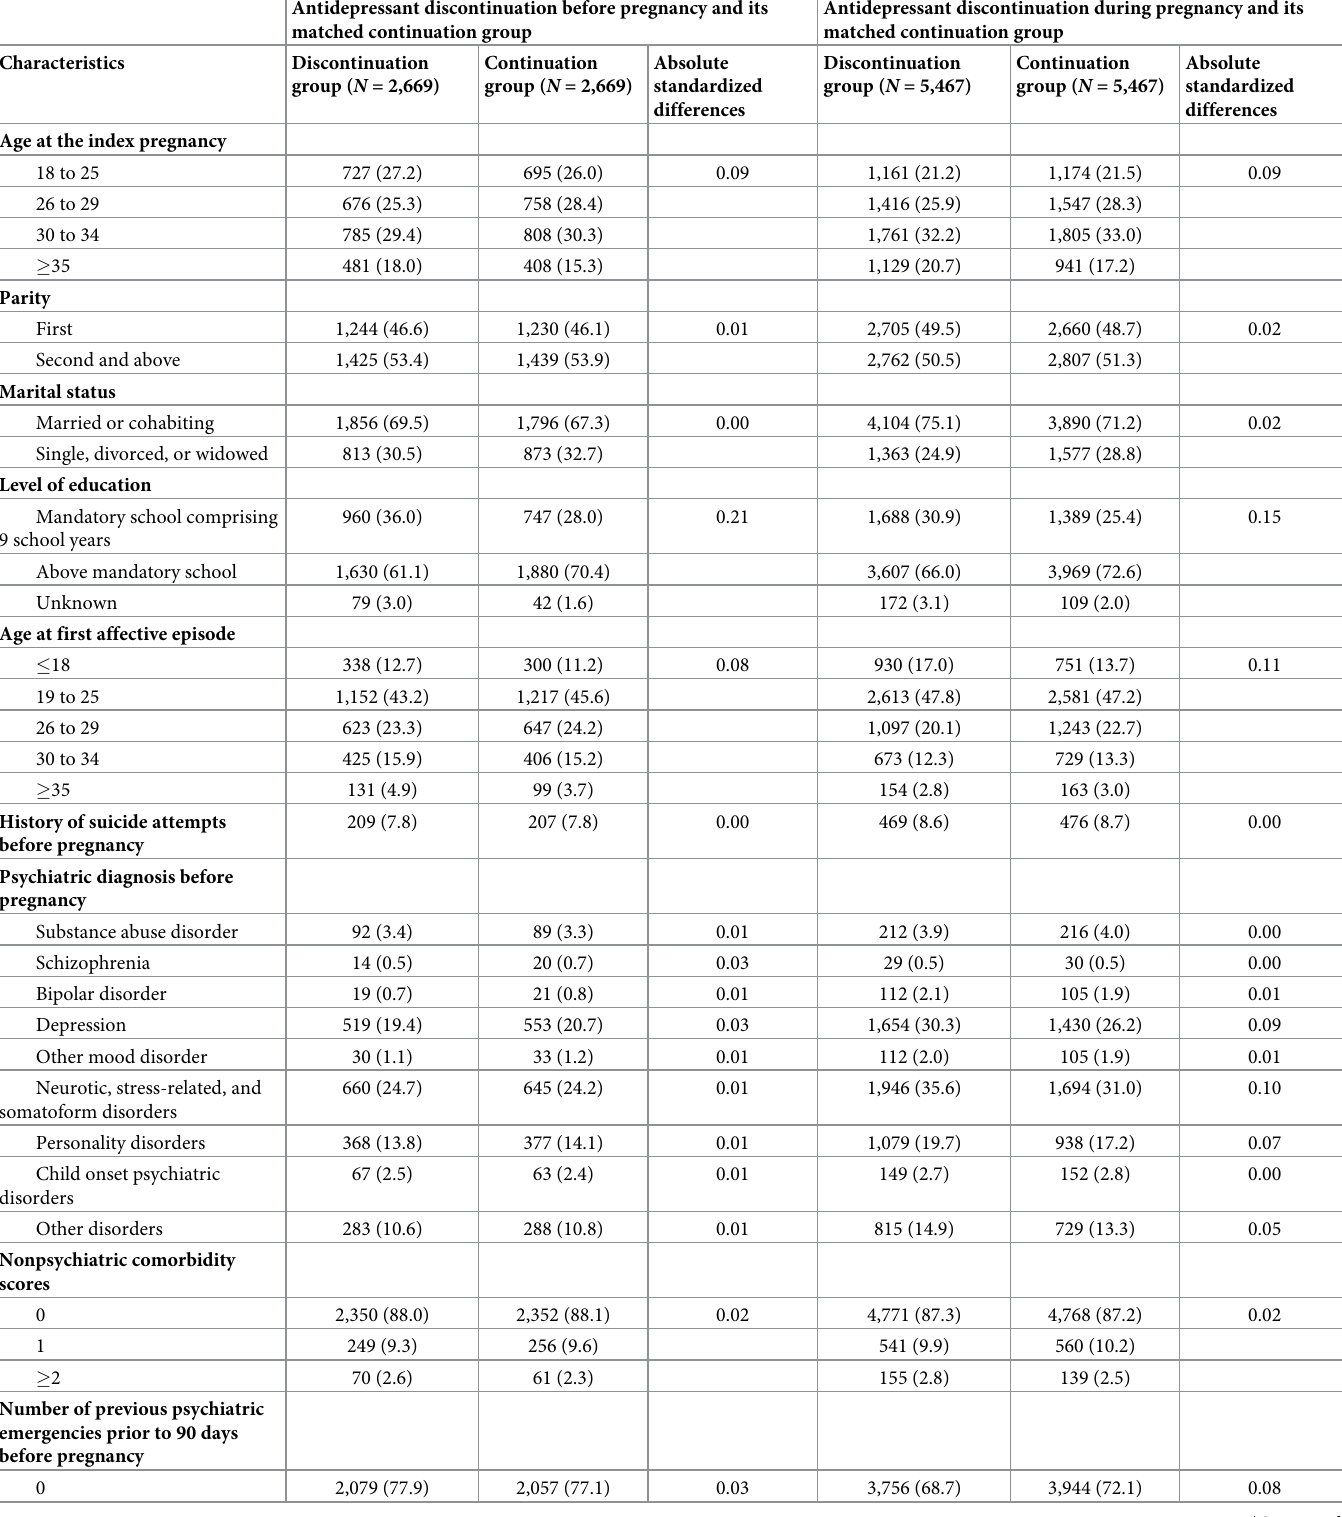
Table 1. Characteristics of the study population after propensity score